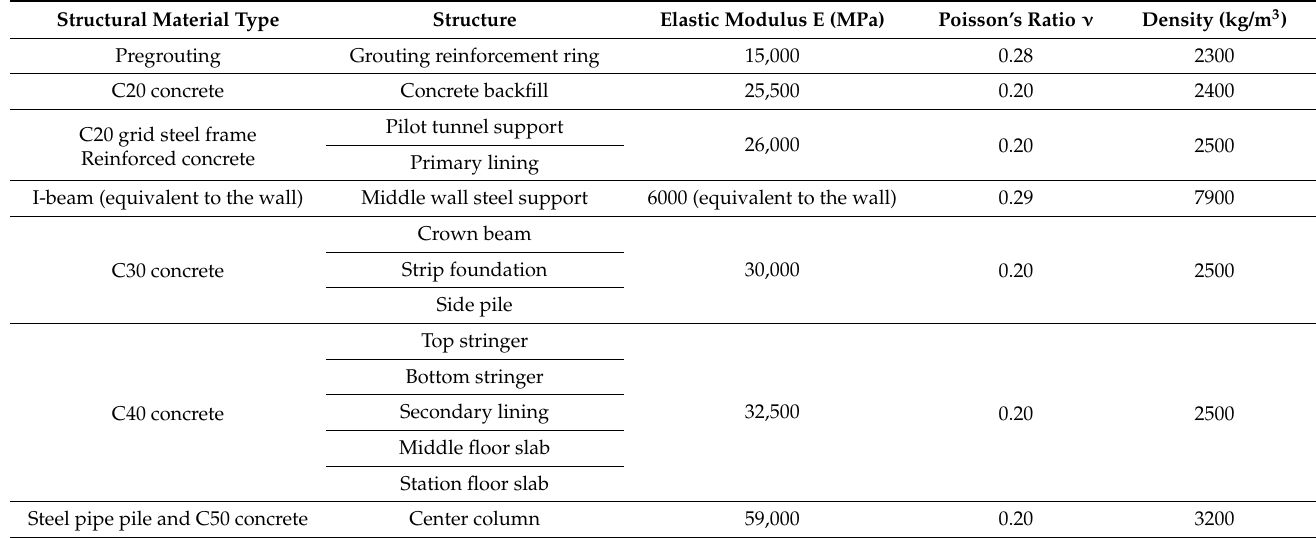
Table 3. Physical and mechanical parameters of supporting structure.